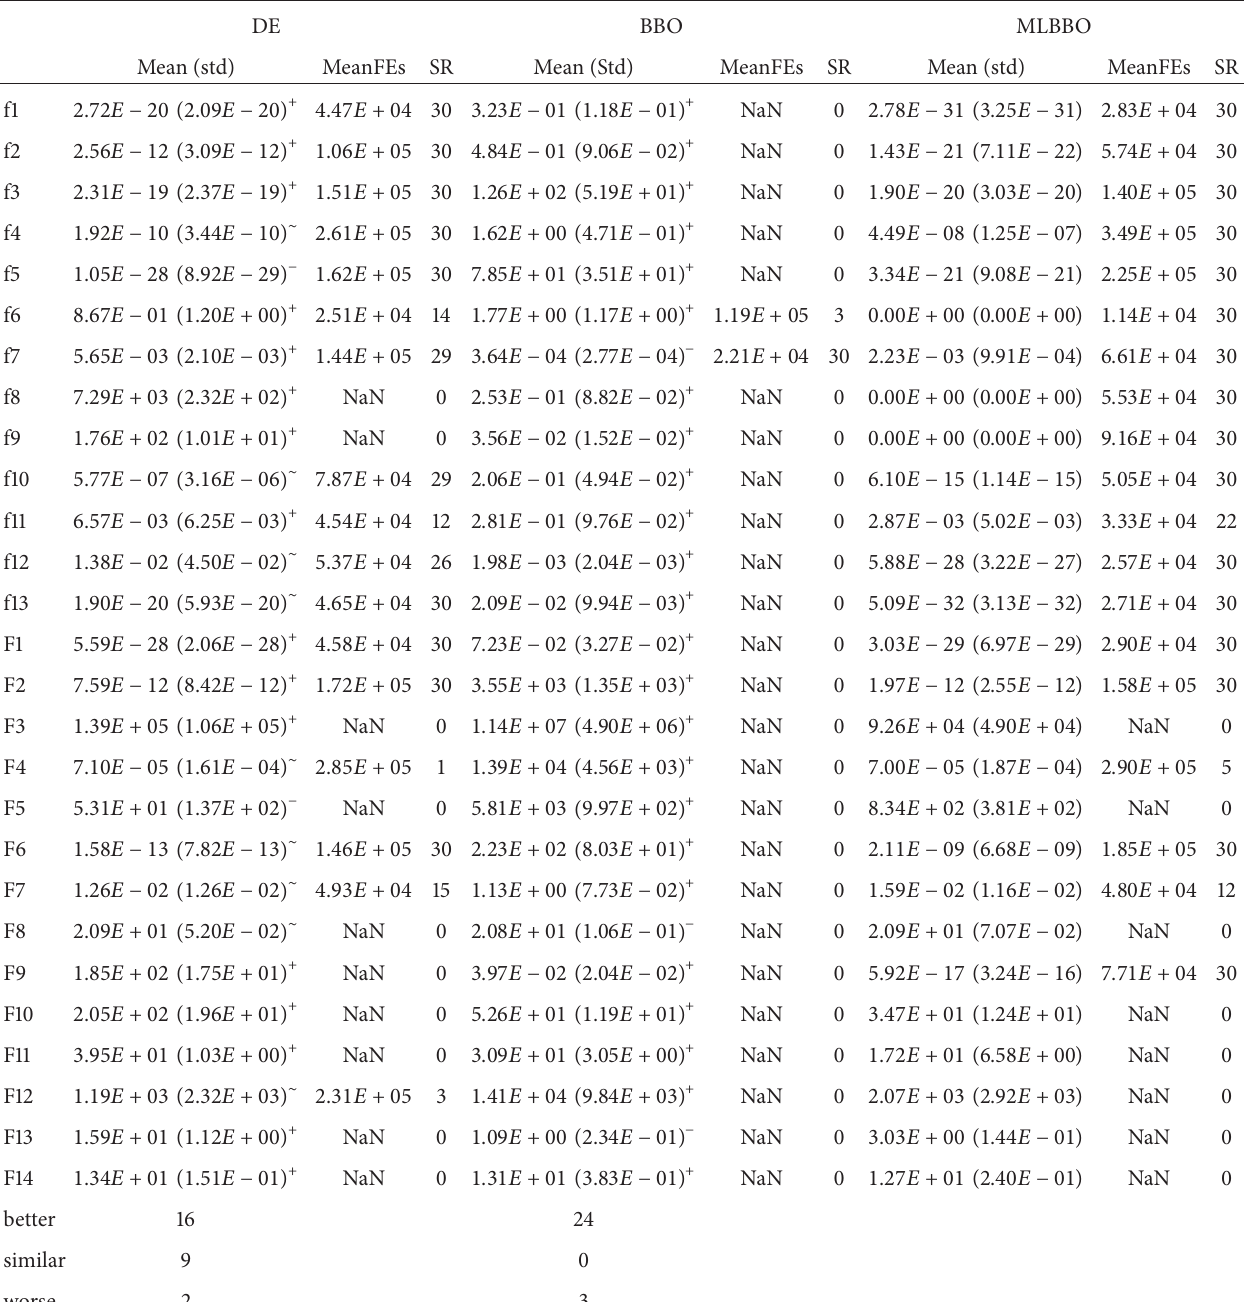
Table 2: Comparisons with BBO and